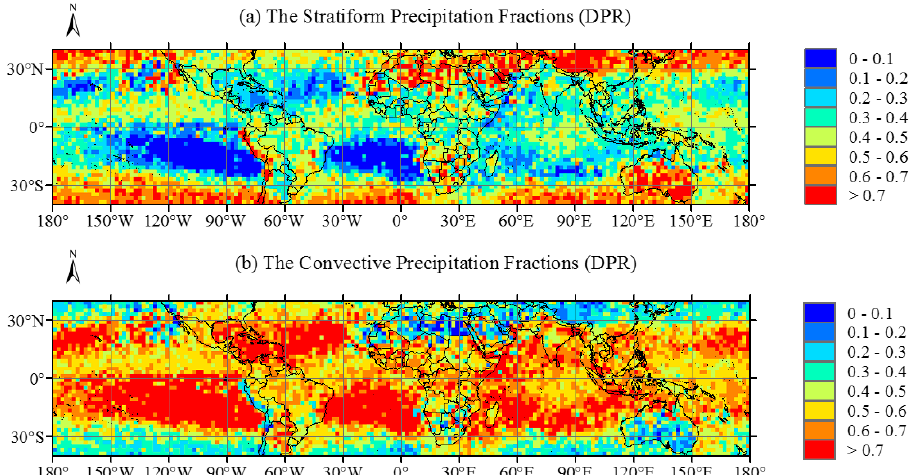
Figure 3. Global distribution of the fractions for: ( a ) stratiform; and ( b ) convective precipitation in the total precipitation volume captured by GPM DPR. All data are resampled to a spatial resolution of 2° × 2° and the fraction is calculated as the ratio between the accumulated stratiform/convective precipitation volume and the total precipitation volume.